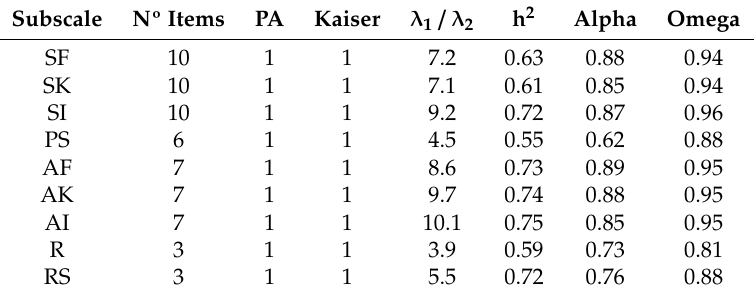
Table 3. Essential unidimensionality of the